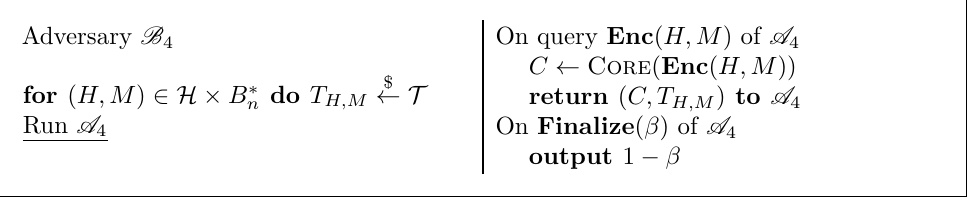
Figure 9: Games PR-TAG-REAL Π (left) and PR-TAG-IDEAL Π (right) used to define PR-TAG .